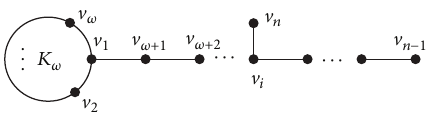
Figure 4: Graph 𝑃𝐾 𝑖 𝑛−𝜔,𝜔 , where 𝑖 = 𝜔 + 1, ...,𝑛 − 1 . . . . K 𝜔